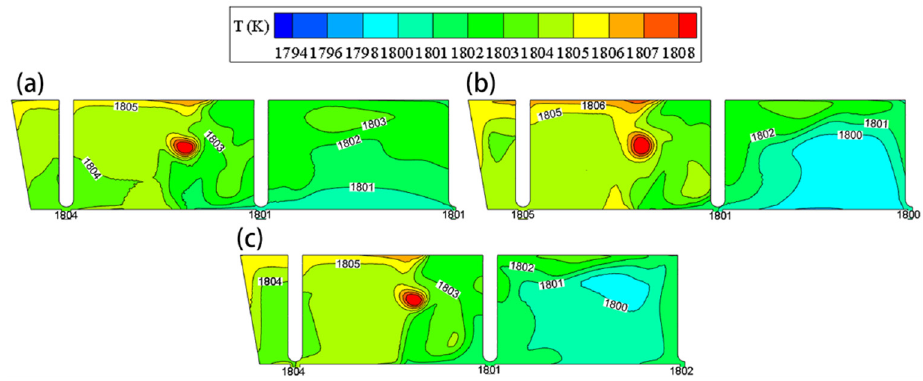
Figure 19. Temperature field in the plane passing through outlet center for different cases: ( a ) FK-A0; ( b ) FK-A5; ( c ) FK-A15.